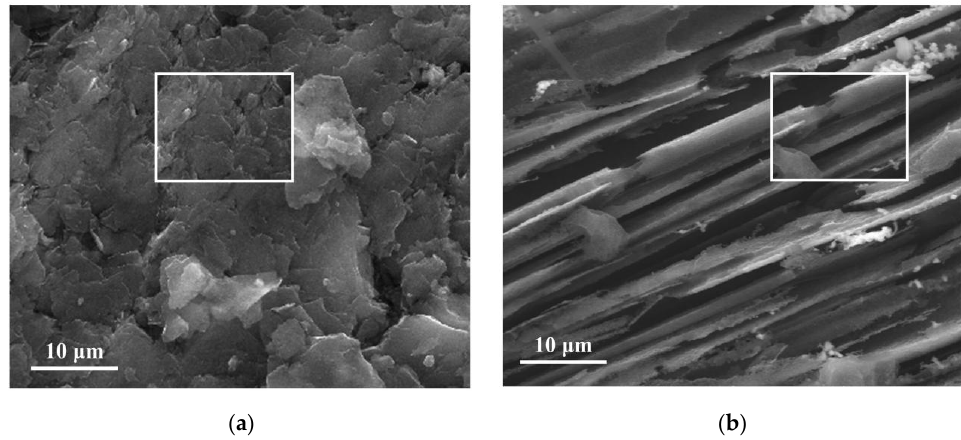
Figure 11. SEM images: ( a ) fresh anode surface; ( b ) anode surface after normal electrolysis. The XPS wide-range spectrum of the graphite anode after electrolysis is shown in Figure 12a. There are a C 1s peak, an O 1s peak, a F 1s peak, a Na 1s peak and a Al 2p peak. Among them, Al and Na come from electrolytes, which have nothing to do with the chemical reaction on the anode. The elements C, O and F were further analyzed. The C1s high-resolution spectrum contains six components (Figure 12b). The strongest peak C1 at 284.89 is the graphite sp2 carbon. Peak C 2 at 284.94 eV is the non-functional sp3 carbon in the graphite aromatic ring. The adsorption energy of C 3 peak is 286.44 eV, which may correspond to a -CH x -OH or -C-O-C- structure [37–39].C4 with an adsorption energy of 287.04 eV corresponds to -C=O structure [40]. C1s with an adsorption energy higher than 288 eV is fluoridated to form a C 5 semi-ionic C-F bond and a C 5 ion C-F bond [41]. C 6 with the lowest content has an adsorption energy of 294.39 eV, which represents the π - π * ex- cited satellite peak structure. It can be seen from Figure 12c that the O 1s high-resolution spectrum contains five components, among which C 1 and C 2 with an adsorption energy of 530.14 and 530.44 eV correspond to a -OH structure, and C 3 and C 4 with adsorption energy of 531.14 and 531.94 eV indicate a -C=O structure. C 5 with an adsorption energy of 533.02 eV is a C-O-C- bridge structure. For the F 1s high-resolution spectrum, there are four components, all of which are F-C bonds. F 1 with an adsorption energy of 687.44 eV is a semi-ionic F-C bond. F 2 and F 3 with adsorption energies of 687.79 and 687.94 eV repre- sent covalent F-C bonds. The adsorption energy of F 4 is 689.79 eV, which may be a -CF 2 structure. Compared with the F-C bond, the -CF 2 structure is negligible. The bonding anal- ysis on the surface of the graphite anode after electrolysis shows that there are a C=O double bond, a C-O-C bridge structure and a C-F bond at the anode interface after elec- trolysis. This is consistent with the first-principles calculation results, which proves that different C-O bonds and C-F bonds are formed during the discharge of O and F.